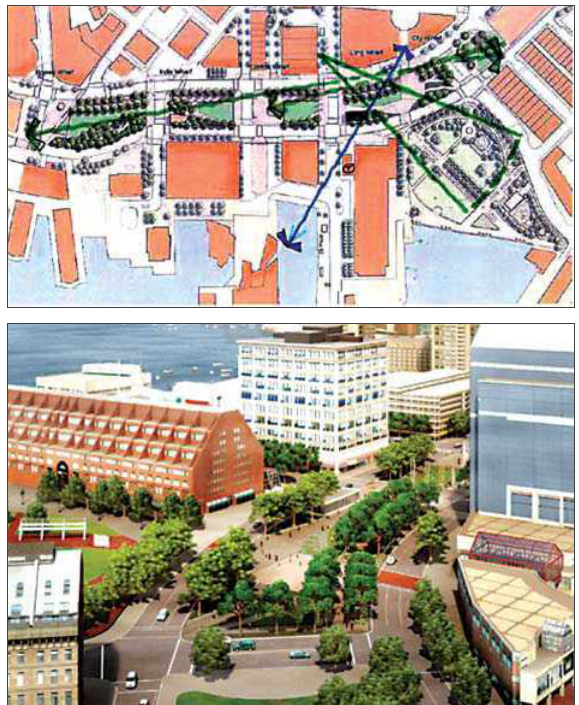
Fig 6. Visualization of Harbor Islands Park in Boston